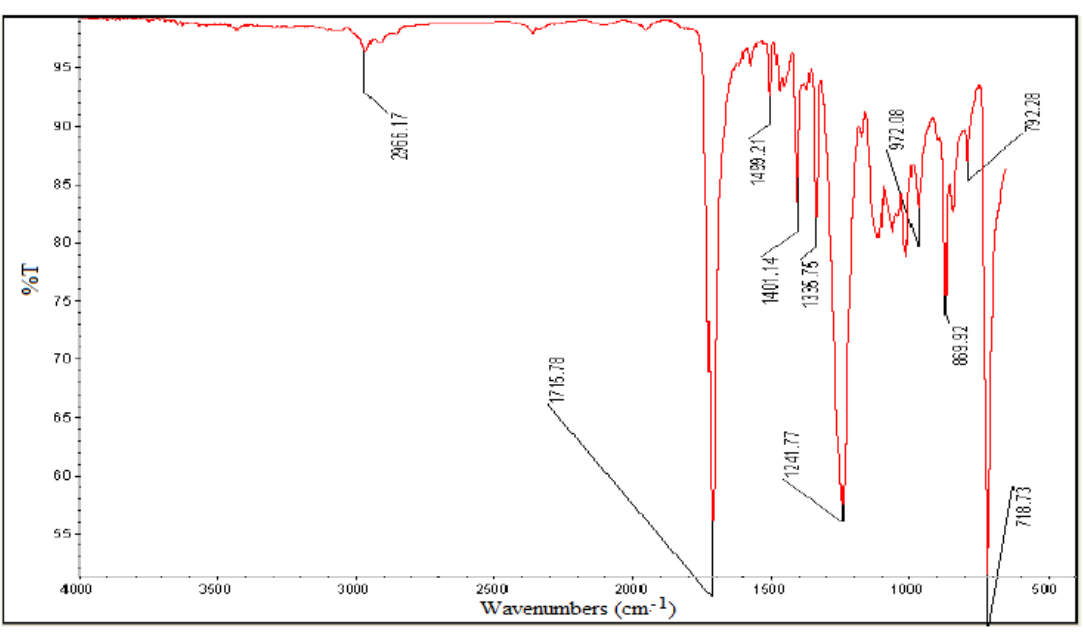
Figure 2. FTIR of Polyester.